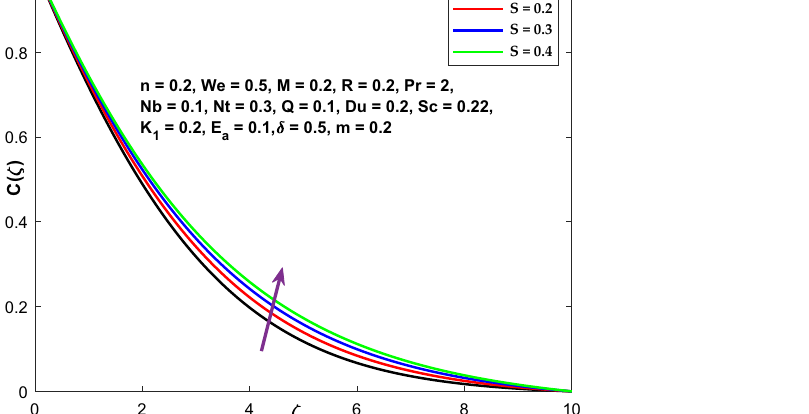
Figure 16. Character of S versus C (ζ) .